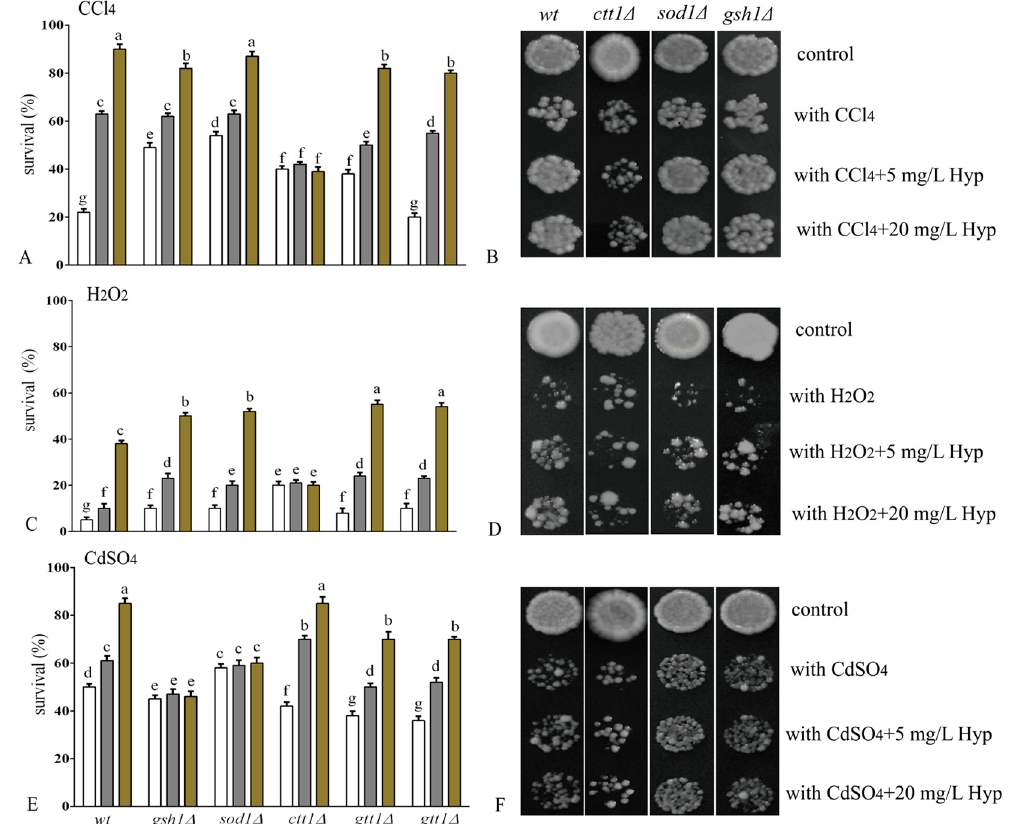
Figure 3. Effect of hyperoside on yeast cells under indicated stress. A , C , E : Effect of 10 mM CCl 4 , 2 mM H 2 O 2 , and 3 mM CdSO 4 on the viability in Saccharomyces cerevisiae cells (wild type and mutant strains ctt1 ∆ , sod1 ∆ , gtt1 ∆ , gtt2 ∆ , and gsh1 ∆ ) and the anti-oxidative effect of hyperoside pre-treatment. The concentration of hyperoside used was 0 mg/L (white bars), 5 mg/L (grey bars), and 20 mg/L (brown bars). B , D , F : Effect of 10 mM CCl 4 , 2 mM H 2 O 2 , and 3 mM CdSO 4 on the growth of S. cerevisiae cells (wild type and mutant strains ctt1 ∆ , sod1 ∆ , and gsh1 ∆ ) and the anti-oxidative effect of hyperoside pre-treatment. The results represent the means ± SD from three independent experiments. The statistically different results were represented by different letters in each oxidative stress group, p < 0.05.